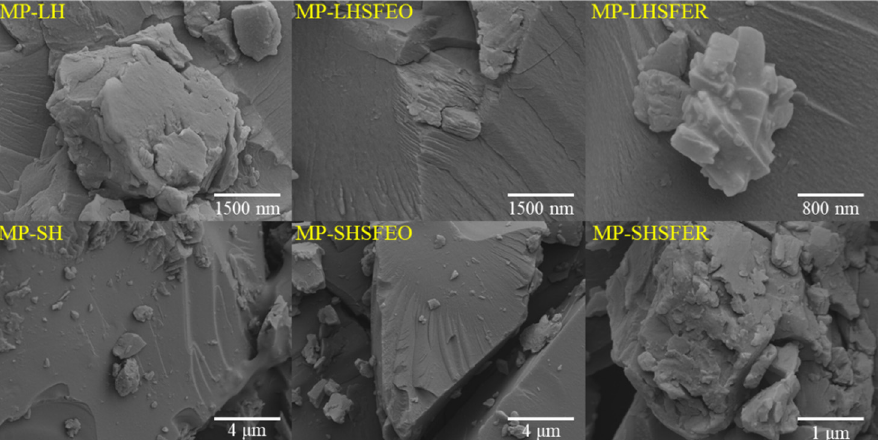
Figure 16. SEM images of SLO and SFEO thermal conversion products.